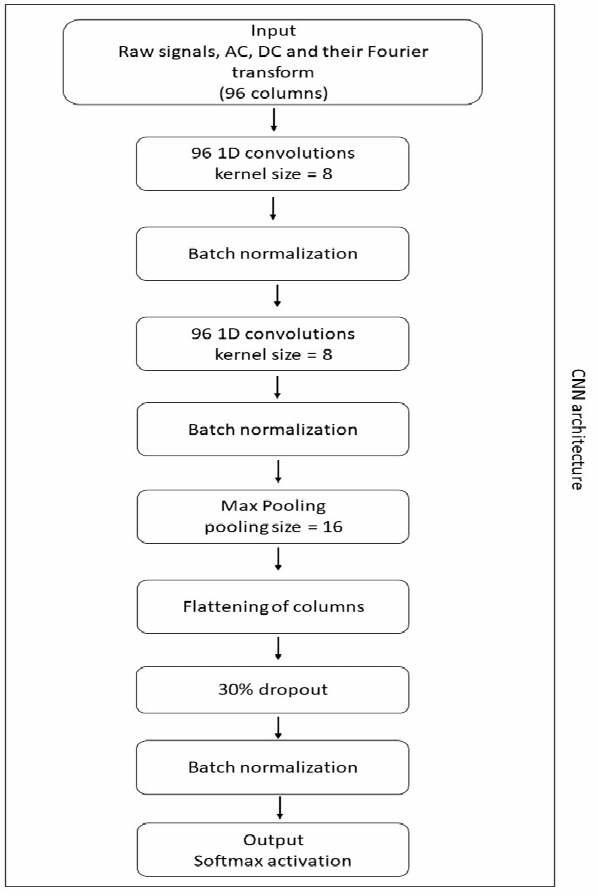
Figure 2. The architecture of the convolutional neural network tested here. Except for the output, all layers were activated with the RELU function.